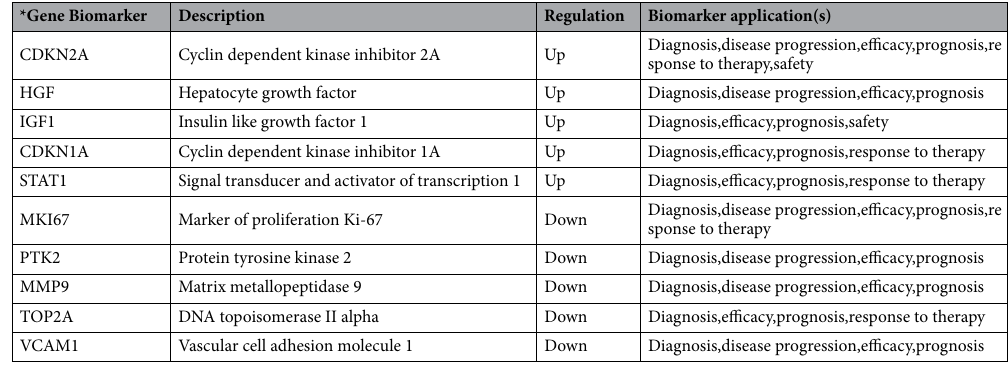
Table 5. Common molecular biomarker candidates for diagnosis, disease progression, efficacy, prognosis, response to therapy and safety in multiple myeloma.